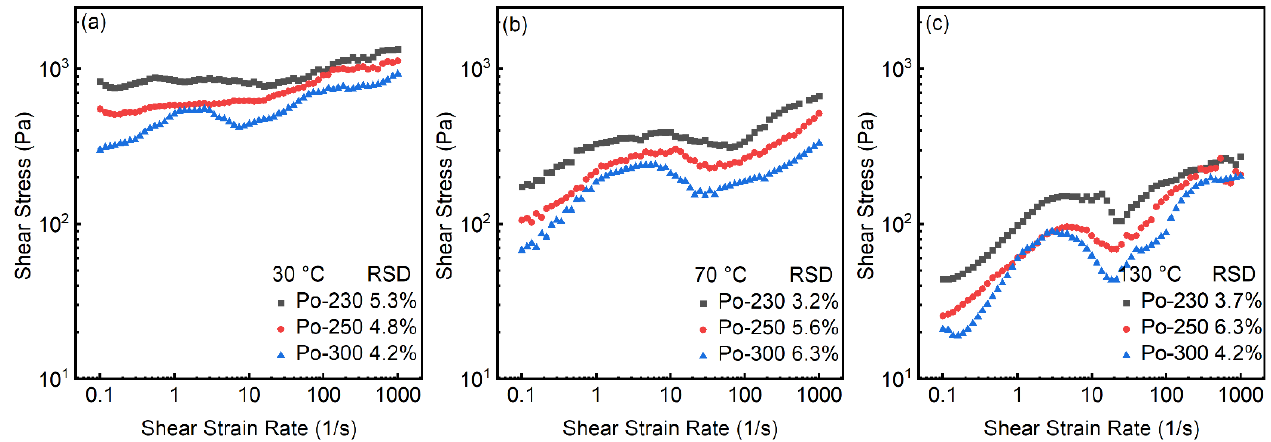
Figure 6. Variations in shear stress of polyurea grease with shear strain rate at different temperatures: ( a ) 30 °C, ( b ) 70 °C, ( c ) 130 °C.